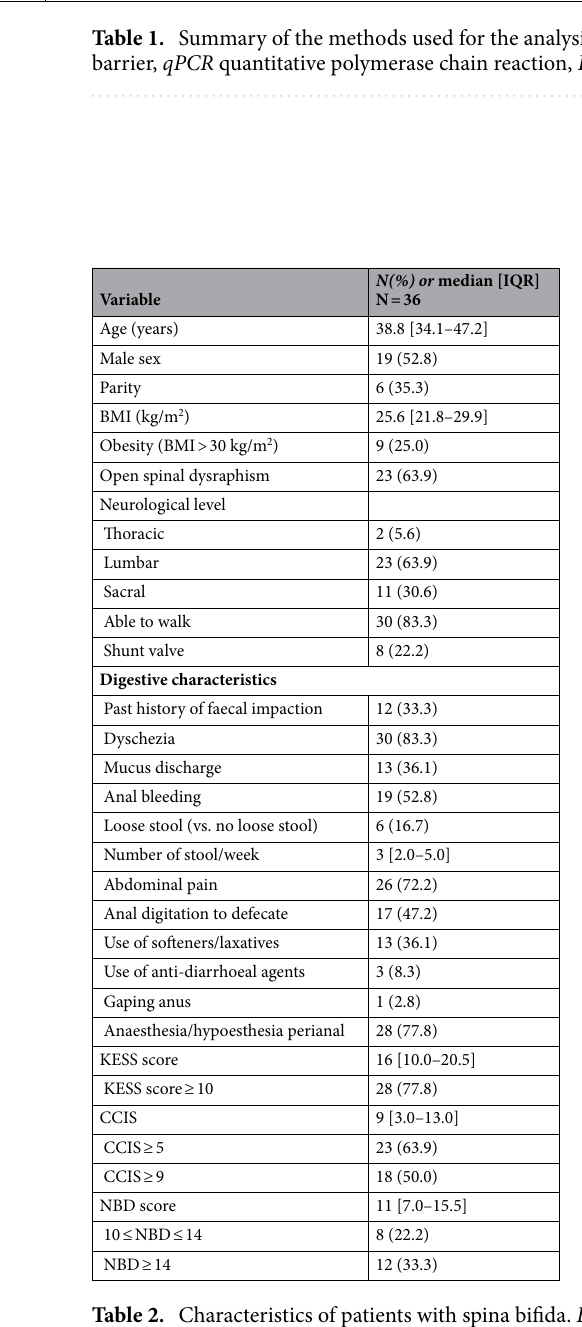
Table 2. Characteristics of patients with spina bifida. BMI body mass index, CCIS Cleveland Clinic Incontinence Score, KESS Knowles-Eccersley-Scott Symptom Constipation Score, NBD neurogenic bowel dysfunction, IQR interquartile range 25% and